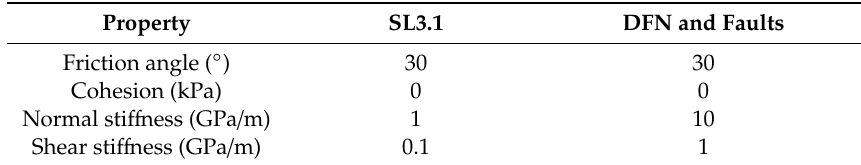
Table 4. Discontinuity properties assumed for numerical modelling of the San Leo landslide in Slope Model.